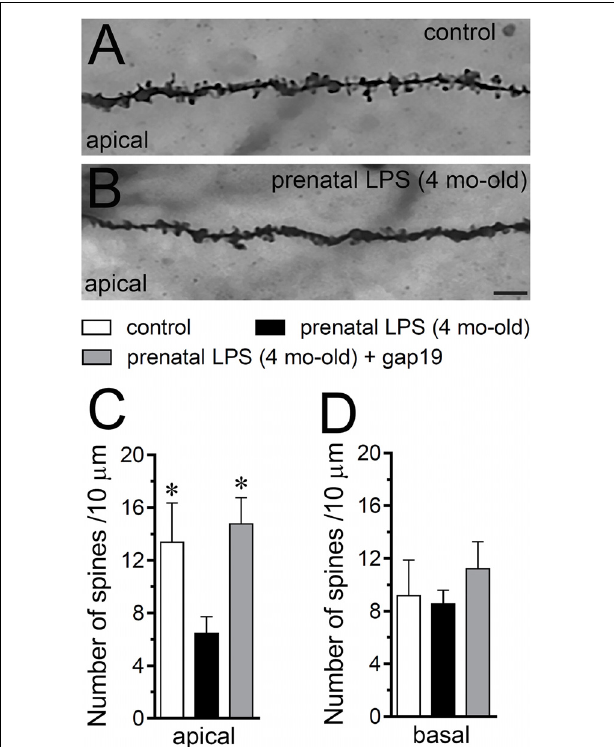
FIGURE 7 | Prenatal LPS exposure increases spine density in apical but not basal dendrites of CA1 pyramidal neurons, a response based on the activation of Cx43 hemichannels. (A,B) Representative golgi (black) staining by apical dendrites of CA1 pyramidal neurons from control offspring (A) or prenatally LPS-exposed offspring of 4 months old (B) . (C,D) Averaged data of the number of apical (A) or basal (B) dendritic spines by CA1 pyramidal neurons from control offspring (white bars) or prenatally LPS-exposed offspring of 4 months old alone (black bars) or in combination with the in vivo administration of 23 mg/kg Tat-gap19 (gray bars). ∗ p < 0.05 versus LPS, one-way ANOVA Tukey’s post hoc test, mean ± S.E.M., n = 3. Calibration bar = 3 µ